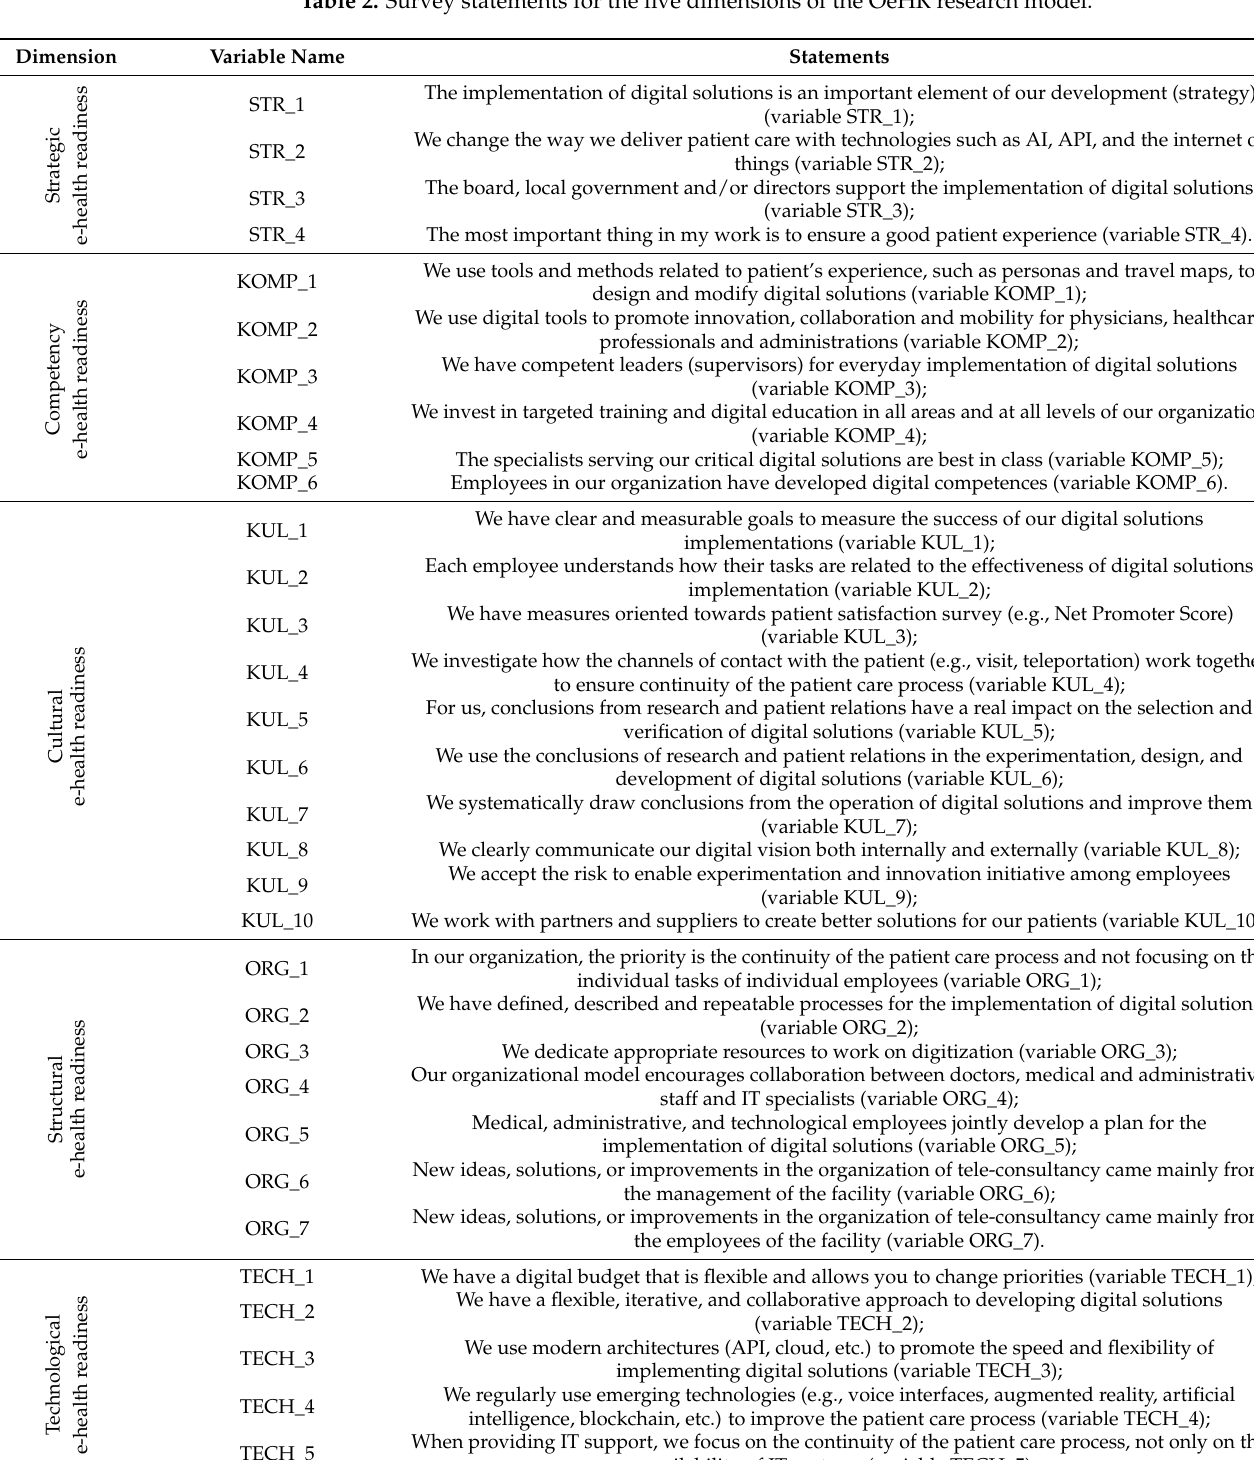
Table 2. Survey statements for the five dimensions of the OeHR research